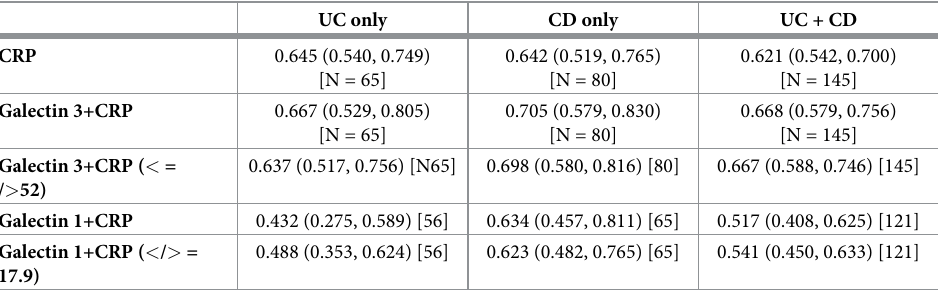
Table 5. Combination of galectins-1 and -3 and CRP in active and inactive UC and CD. UC only P value SCCAI � 2 SCCAI > 2 All Galectin 1+CRP N 23 33 56 Mean (SD) 119.5 (246.3) 21.0 (21.1) 61.4 (164.1) Median (range), 17.5 (0.2, 822.1) 16.1 (0, 82.3) 16.5 (0, 822.1) 0.3910 Galectin 3+CRP N 28 37 65 Mean (SD) 45.1 (44.0) 63.1 (47.2) 55.4 (46.3) Median (range) 28.3 (7.2, 219.8) 58.0 (8.2, 233.7) 36.2 (7.2, 233.7) 0.0219 CD only P value HBI � 5 HBI > 5 All Galectin 1+CRP N 50 15 65 Mean (SD) 66.4 (246.6) 30.4 (24.9) 58.1 (216.6) Median (range) 14.6 (0.3, 1308) 23 (0.6, 80.3) 15.4 (0.3, 1308) 0.1176 Galectin 3+CRP N 59 21 80 Mean (SD) 46.3 (42.4) 62.0 (28.1) 50.4 (39.6) Median (range) 41.4 (0, 297.1) 55.3 (20.6, 124.1) 46.8 (0, 297.1) 0.0056